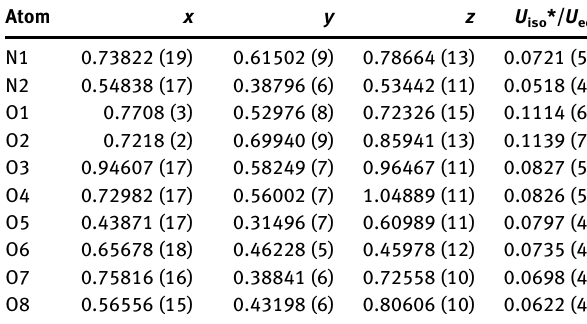
Table  : Fractional atomic coordinates and isotropic or equivalent isotropic displacement parameters (Å 